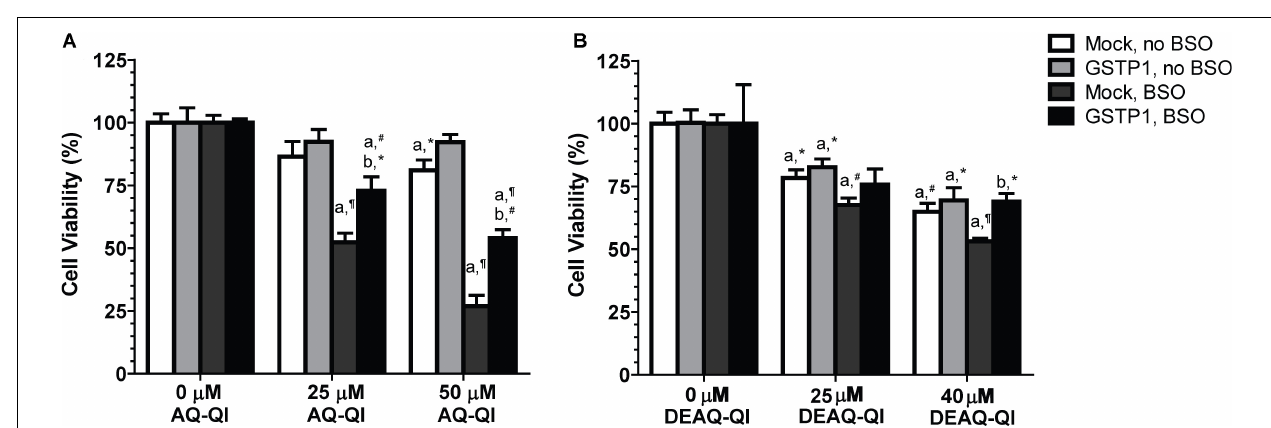
FIGURE 3 | Effect of GSTP1 in protection against AQ-QI- (A) and DEAQ-QI- (B) induced loss of cell viability. AQ-QI and DEAQ-QI were incubated with 1 × 10 4 HepG2 cells transiently transfected with mock or GSTP1 gene for 2.5 h. GSH depletion was performed by addition of BSO (500 µ M) 24 h before the exposure of AQ-QI and DEAQ-QI. Cells were recovered overnight and cell viability was measured by resazurin reduction activity. Results were normalized with setting vehicle controls under each treatment at 100%. Results are presented as mean ± SD ( n = 3). Statistical significant differences with corresponding vehicle control are denoted with ‘a’ and with corresponding mock-transfected control are denoted with ‘b’ using the following p -values: ∗ p < 0.05, # p < 0.01, ¶ p < 0.001; analyzed by Student’s t